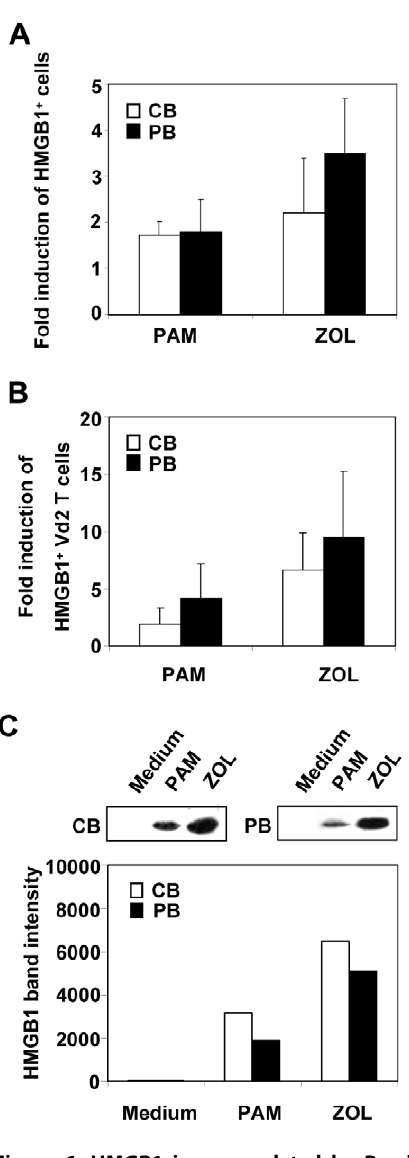
Figure 6. HMGB1 is up-regulated by Pamidronate and Zole- dronate in CB and PB cells. Mononuclear cells isolated from CB and PB have been treated with Pamidronate (1 m g/ml) and Zoledronate (1 m g/ml). (A) After 14 days, cell surface expression of HMGB1 has been analyzed by FACS analysis and the values, shown as fold induction, are the product of ratio between treated and untreated cells expressing HMGB1. (B) By multi-color flow cytometric analysis, CB and PB cells have been gated for lymphocytes and stained with HMGB1, CD3 and gammadelta (V d 2) antibodies. The ratio between treated and untreated HMGB1 + CD3 + cells is shown as fold induction. The values reported are mean 6 SD of four experiments from different donors. (C) The secretion of HMGB1 in cell culture medium was evaluated by western blot analysis. Densitometric analysis of western blot has been expressed as arbitrary units. Western blot is representative of three independent experiments.